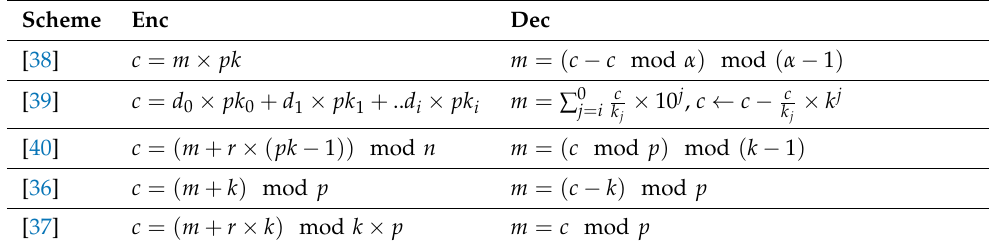
Table 1. Schemes that use k + r × p as a public key.